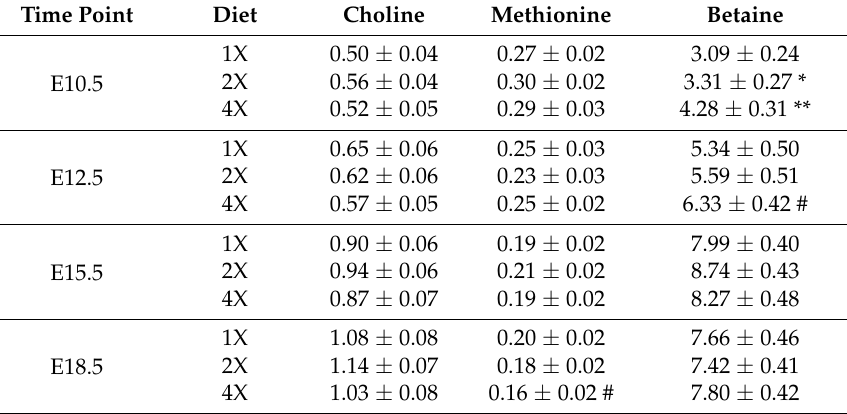
Table 2. Placental concentrations of choline metabolites ( µ mol metabolite/g tissue) at E10.5, E12.5, E15.5, and E18.5 by choline treatment. Data were analyzed using mixed linear models with treatment, genotype, sex, and litter size as fixed effects and maternal ID as random effect. Values are presented as mean ± SEM. * Significantly different versus control diet, p ≤ 0.05. ** Significantly different versus 1X and 2X diets, p ≤ 0.05. # p < 0.1 vs. 1X diet. n = 20 placentas per treatment per time point (two to three per